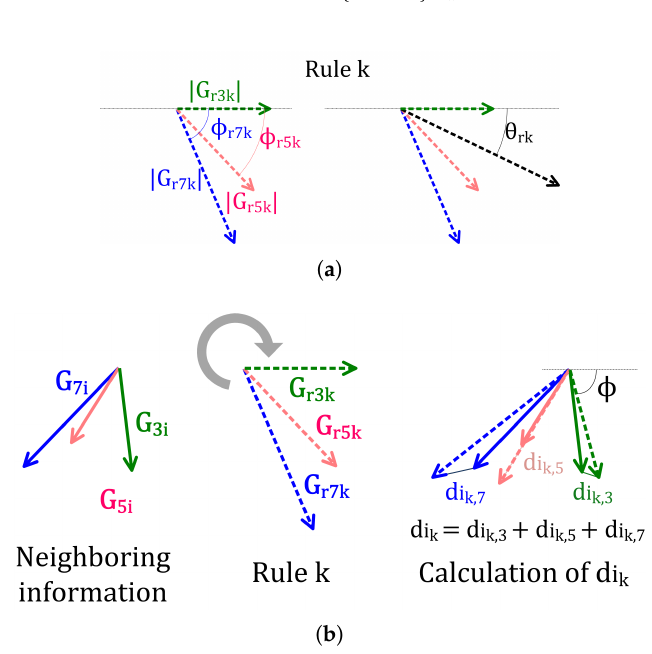
Figure 2. ( a ) Rule representation: (left) condition parameters and (right) action parameter; ( b ) comparison between the neighborhood information of a cell i and the condition parameters of a rule k